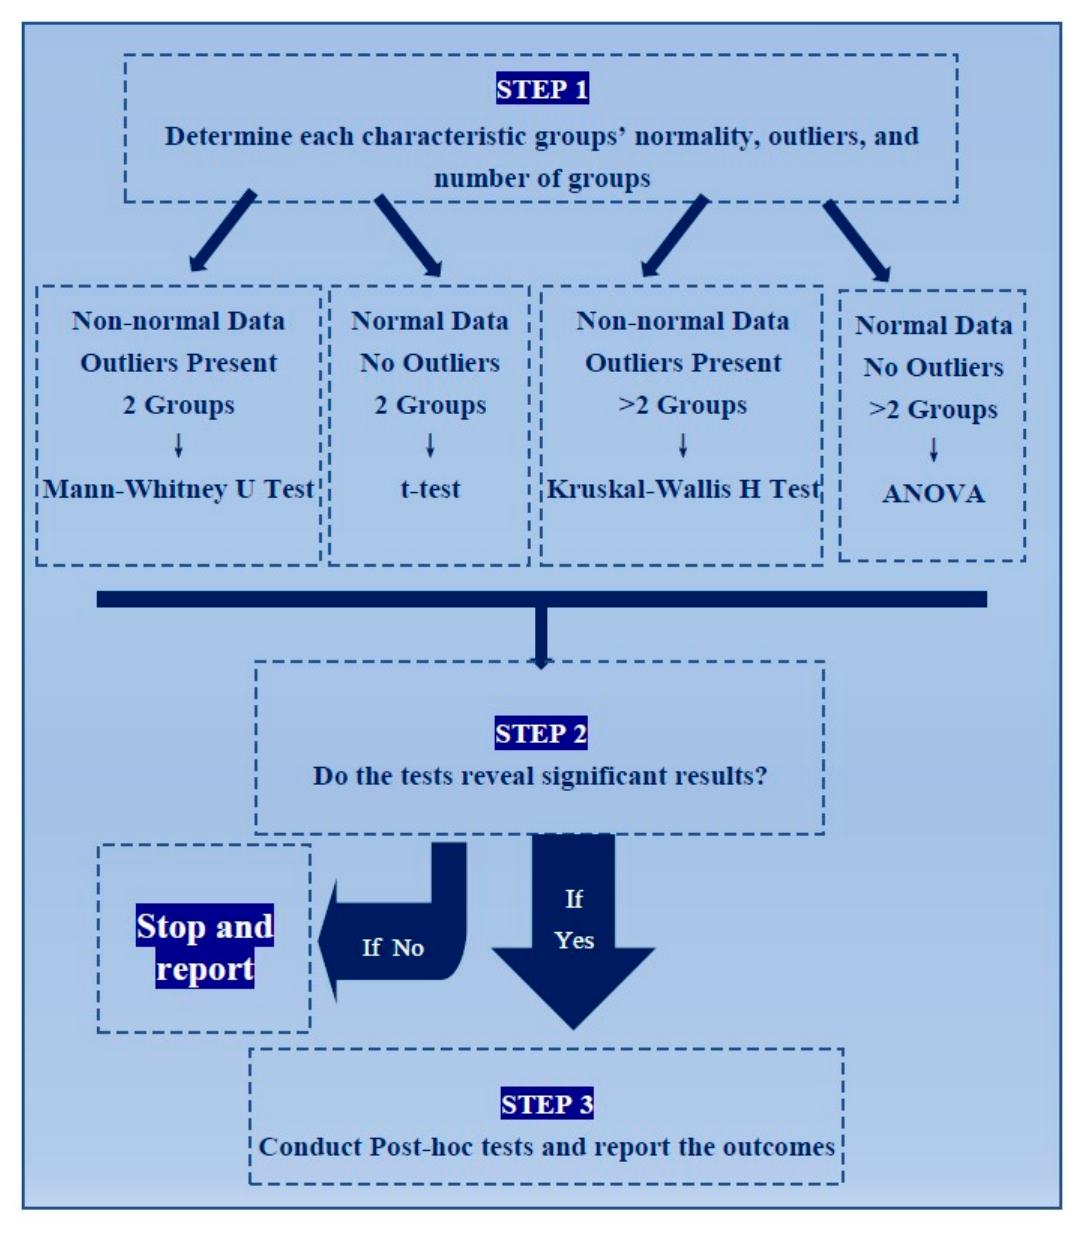
Figure 2. Schematic representation of analysis. The flow chart shows the steps and statistical decisions made in the analysis of data.